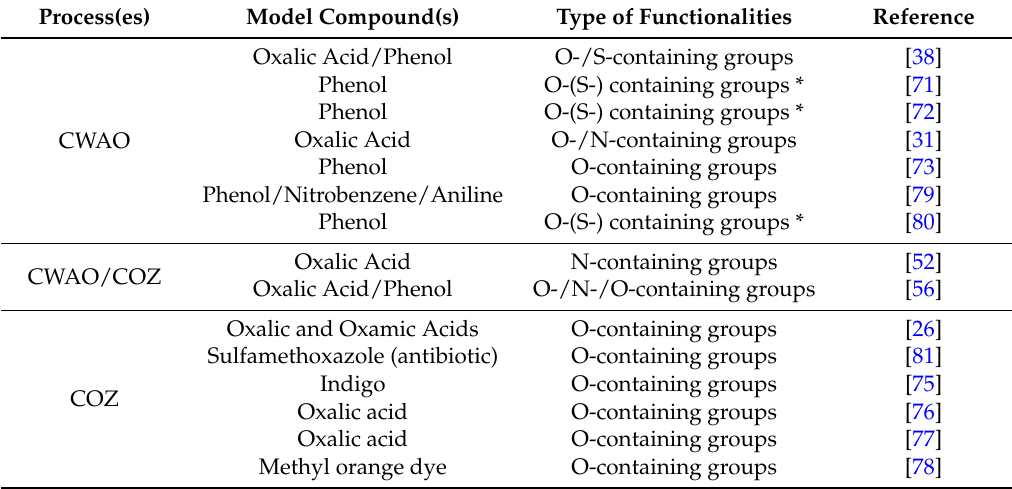
Table 4. Overview of Catalytic Wet Air Oxidation (CWAO) and Catalytic Ozonation (COZ) works from the literature studying different surface functionalities onto the